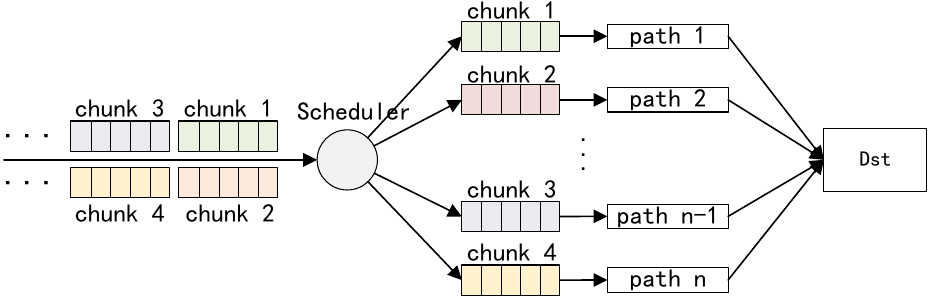
Figure 3. The principle of the multipath data scheduling. Algorithm 2 Data-Scheduling